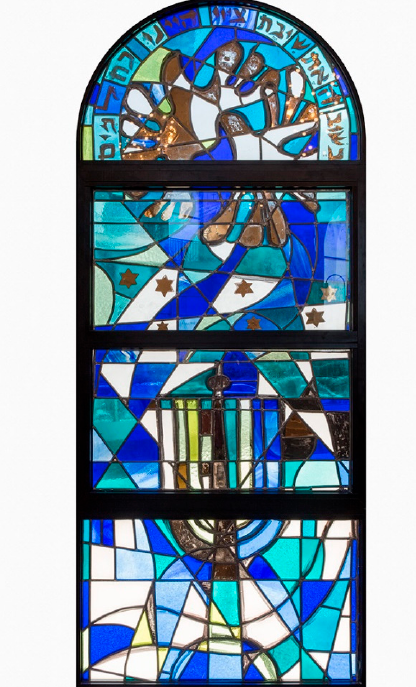
Figure 13. Heichal Yehuda Synagogue, Tel Aviv. Joseph Chaaltiel, stained glass window (detail). Photo: Eli Singalovski, 2018. Used with permission .